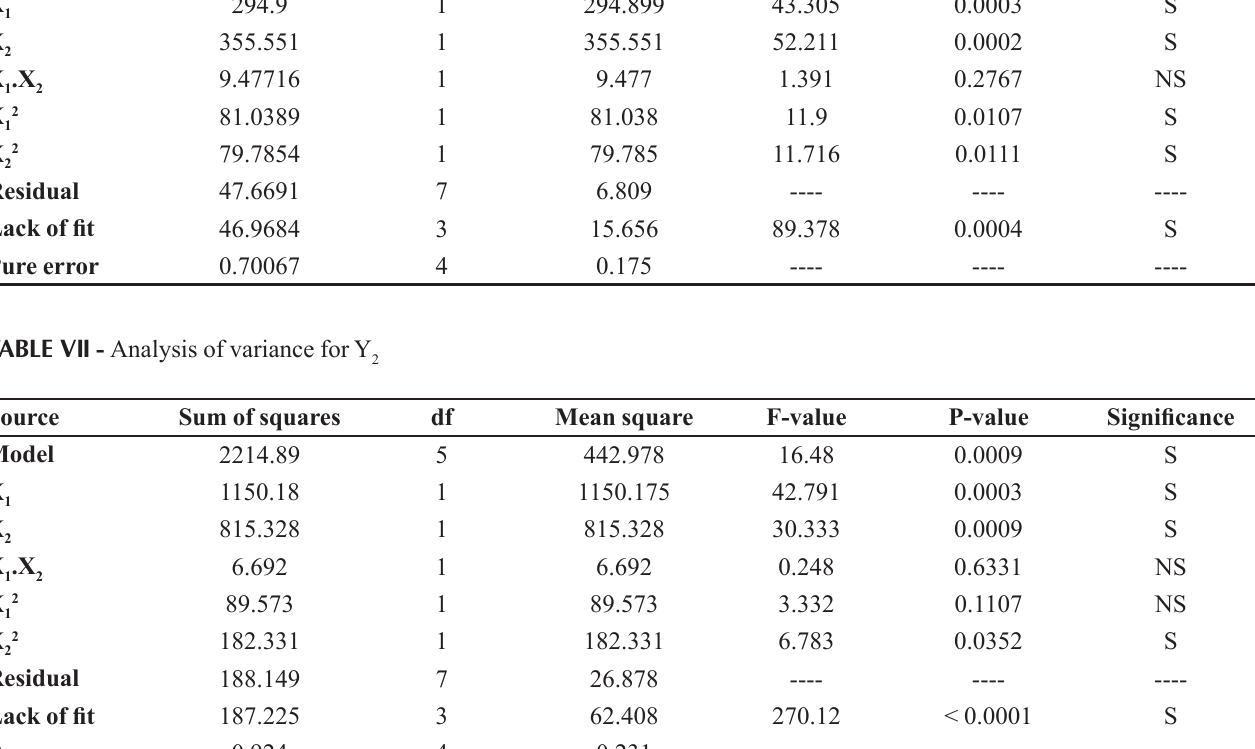
TABLE VI - Analysis of variance for Y Source